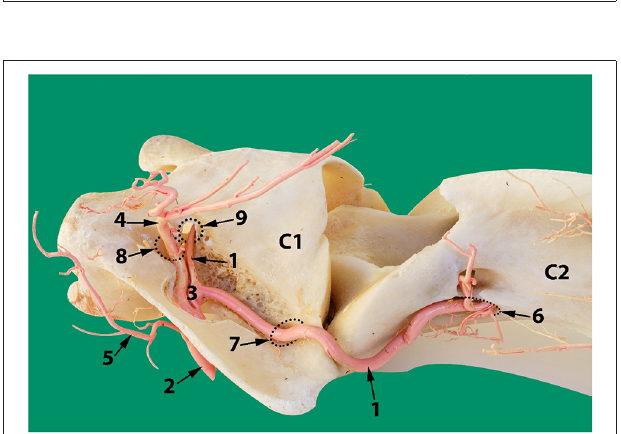
FIGURE 10 | A dorsal view of the second cervical vertebra (axis) after removing the dorsal roof showing the course of the vertebral artery and its branches inside the axis. 1, vertebral artery inside the vertebral canal; 2, vertebral artery after exiting the transverse foramen of the axis; 3, communicating branch between the left and right vertebral arteries (apical arcade); 4, ascending arteries; 5, spinal branch; a, dens of the axis; b, cranial articular process; c, spinal cord reflected from the vertebral canal.